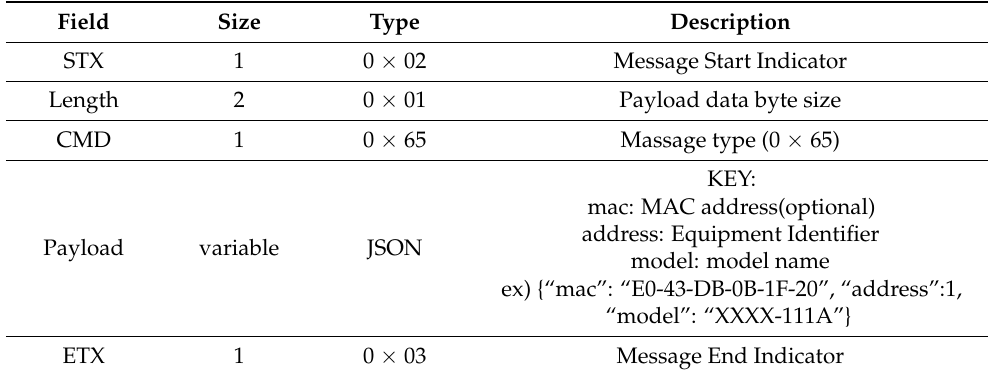
Table 12. Communication protocol for sensor node registration.